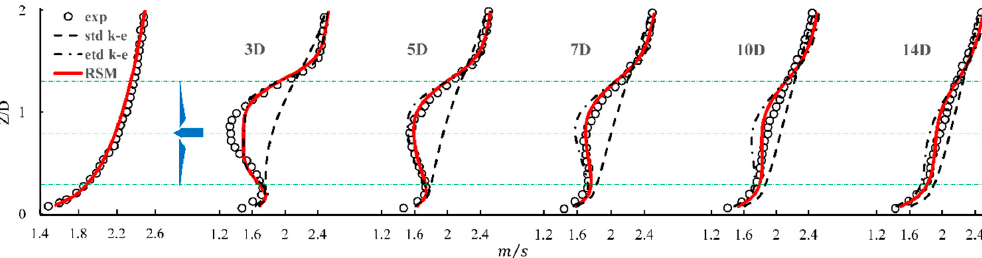
Figure 5. Vertical distribution of stream ‐ wise velocity obtained from: standard k ‐ε model (std. k ‐ e), extended k ‐ε model (etd. k ‐ e) RSM and wind tunnel experiments (exp. data obtained from Wu [40]).